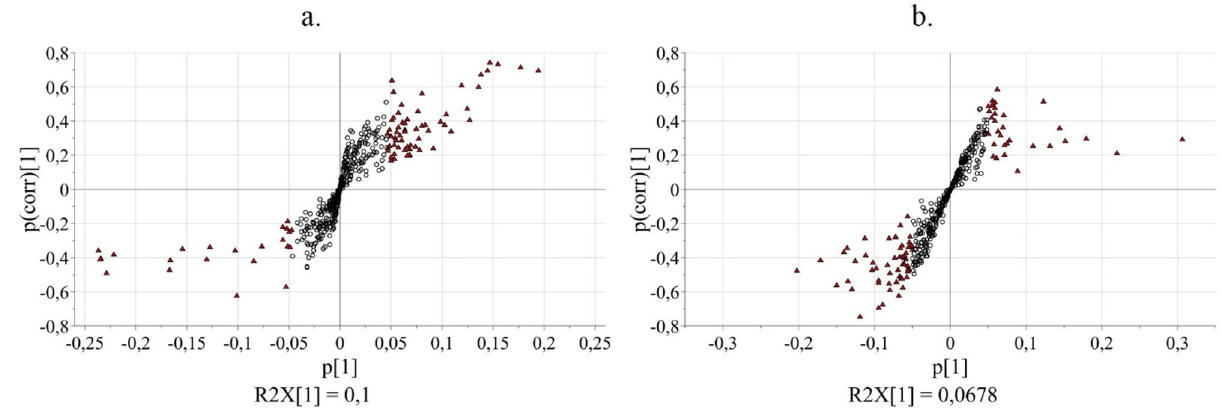
Figure 3. Identification of metabolites with the highest potential as biomarkers by means of the S-plots obtained by applying OPLS-DA to NMR data ( a ) and MS data ( b ). NMR and MS data derives from the analysis of olive leaf samples. The values of p(1) and pcorr(1), relating to the predictive component P1, are displayed; red triangles correspond to x-variables having VIP predictive value >